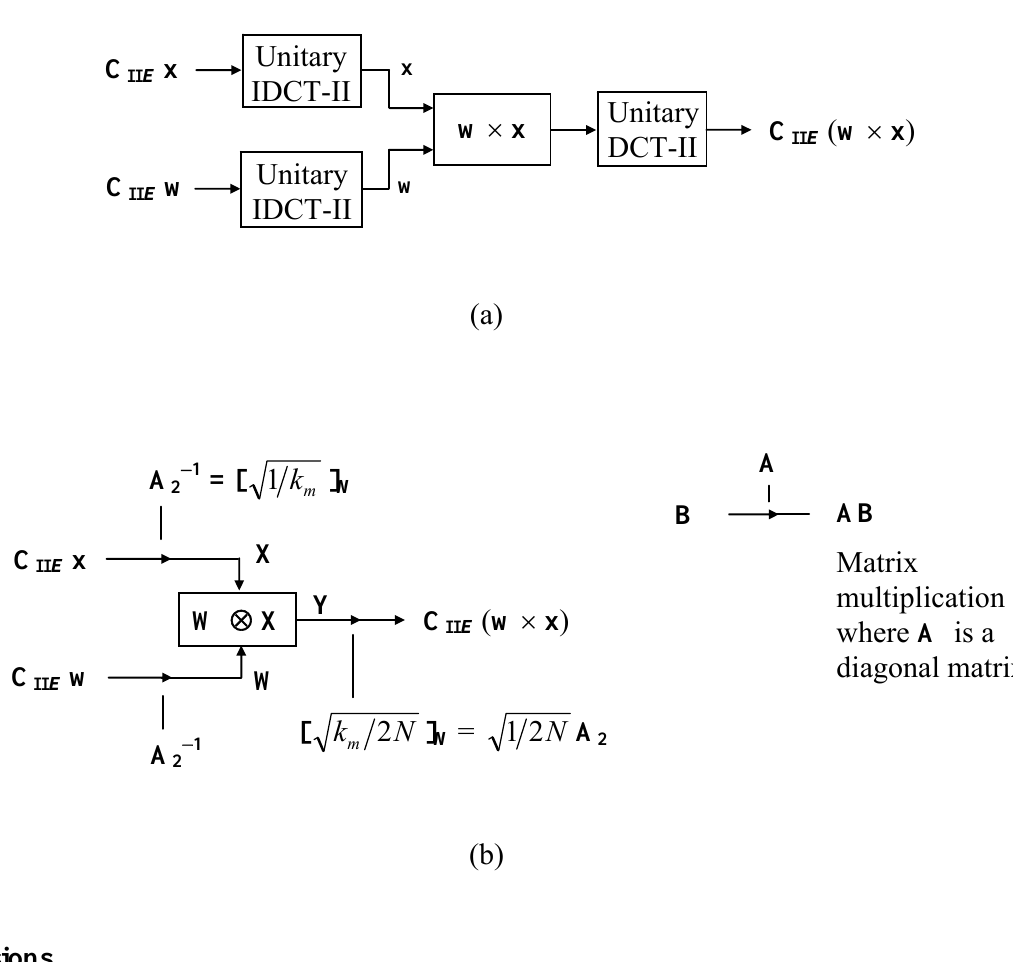
Figure 1. For compressed image / video editing, logo-keying operation (alpha blending) can be done in (a) the spatial and (b) transform domains [1]. The symbol  denotes the element-by-element multiplication of the two vectors and  denotes the symmetric convolution of the two